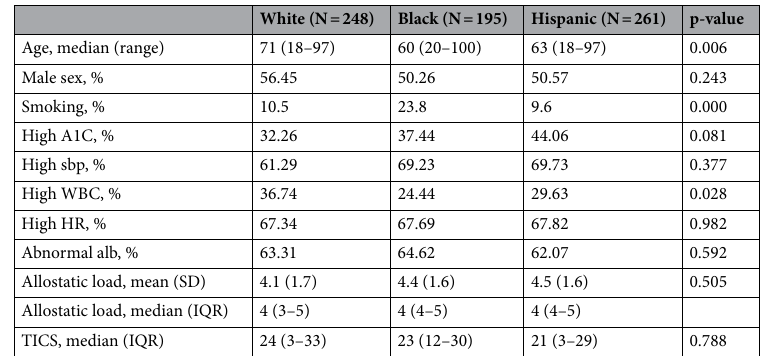
Table 1. Comparison of AL variables between White, Black and Hispanic